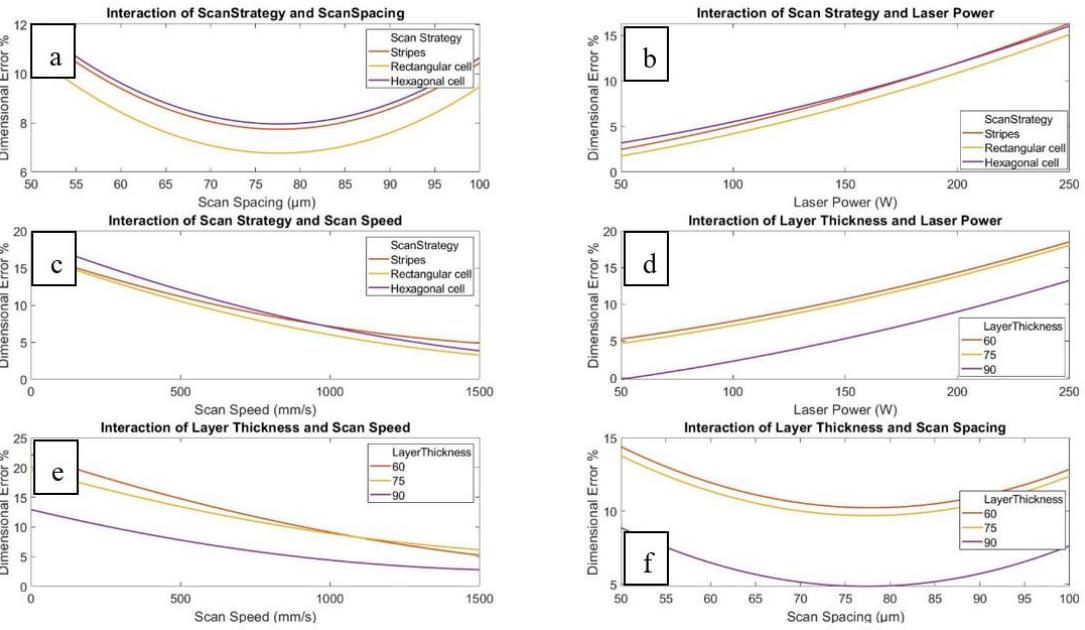
Figure 5. Plots depicting the interaction effects of the scan strategy and layer thickness with the laser power, scan speed, and scan